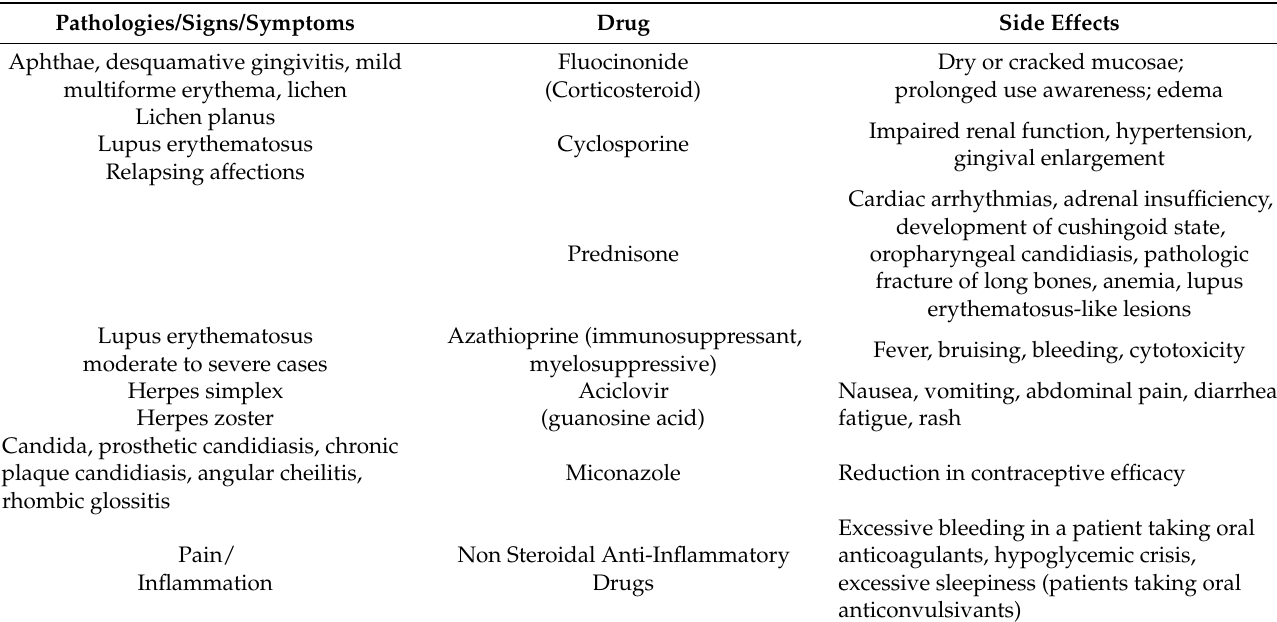
Table 1. Some drugs commonly prescribed in dentistry practice related to side effects (see the Data Availability Statement section for more